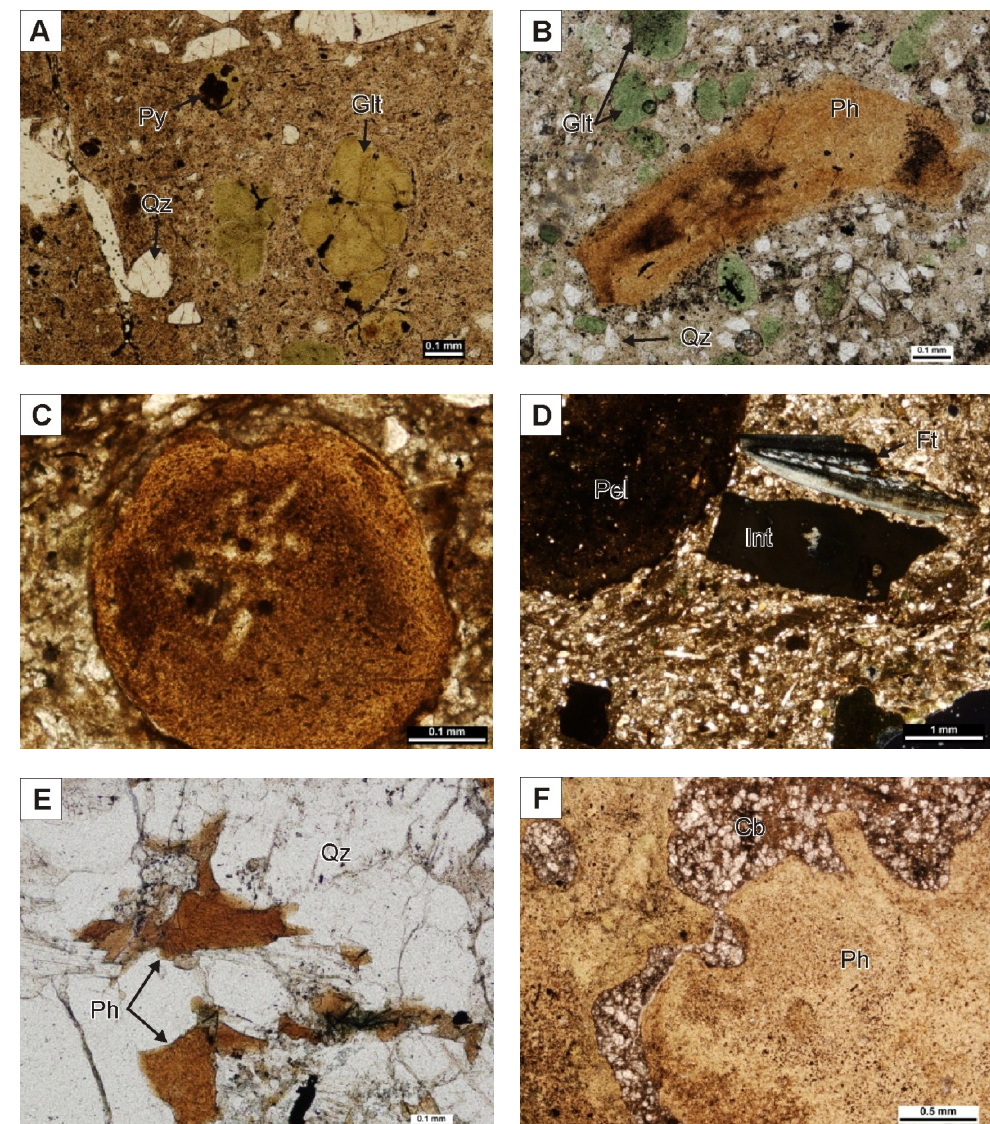
Figure 4. Microscopic textural components. ( A ) Cryptocrystalline apatite of phosphate nodule (brown) showing glauconite pellets (Glt) with pyrite inclusions (Py) and detrital quartz (Qz), (PPL). ( B ) Phosphatized shell fragment (Ph) in calcareous and fossiliferous matrix containing detrital quartz (Qz) (PPL). ( C ) Phosphate peloid (PPL). ( D ) Phosphate peloid (Pel), phosphate intraclasts (Int), and phosphate fish teeth (Ft) in glauconitic mudstone (XN). ( E ) Phosphate cement (Ph) in quartzose sandstone (Qz). ( F ) Fragments of phosphate coprolite (Ph) in carbonate matrix (Cb) (XN).